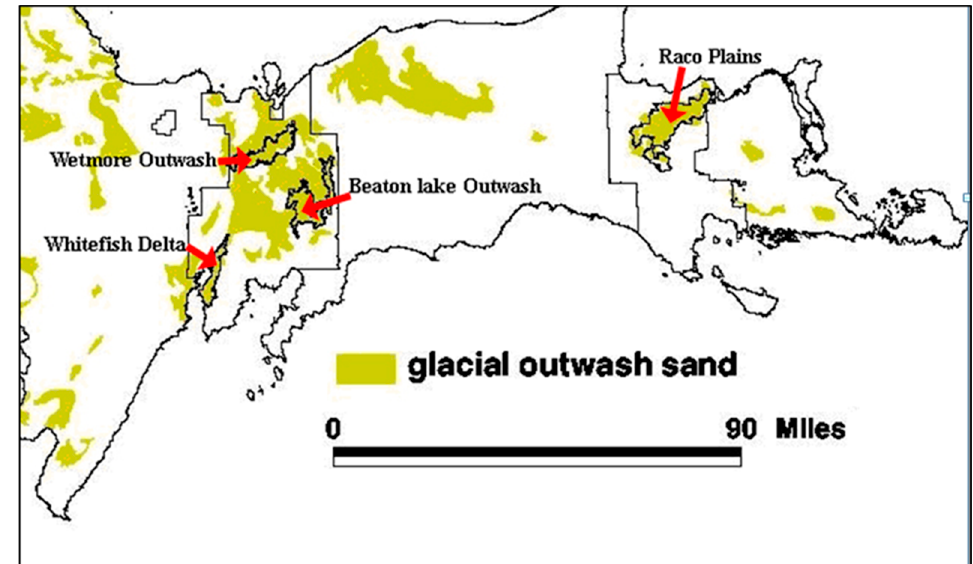
Figure 1. Michigan’s Upper Peninsula (eastern portion) including the Hiawatha National Forest proclamation boundary and glacial outwash plains with potential Kirtland’s warbler habitat.